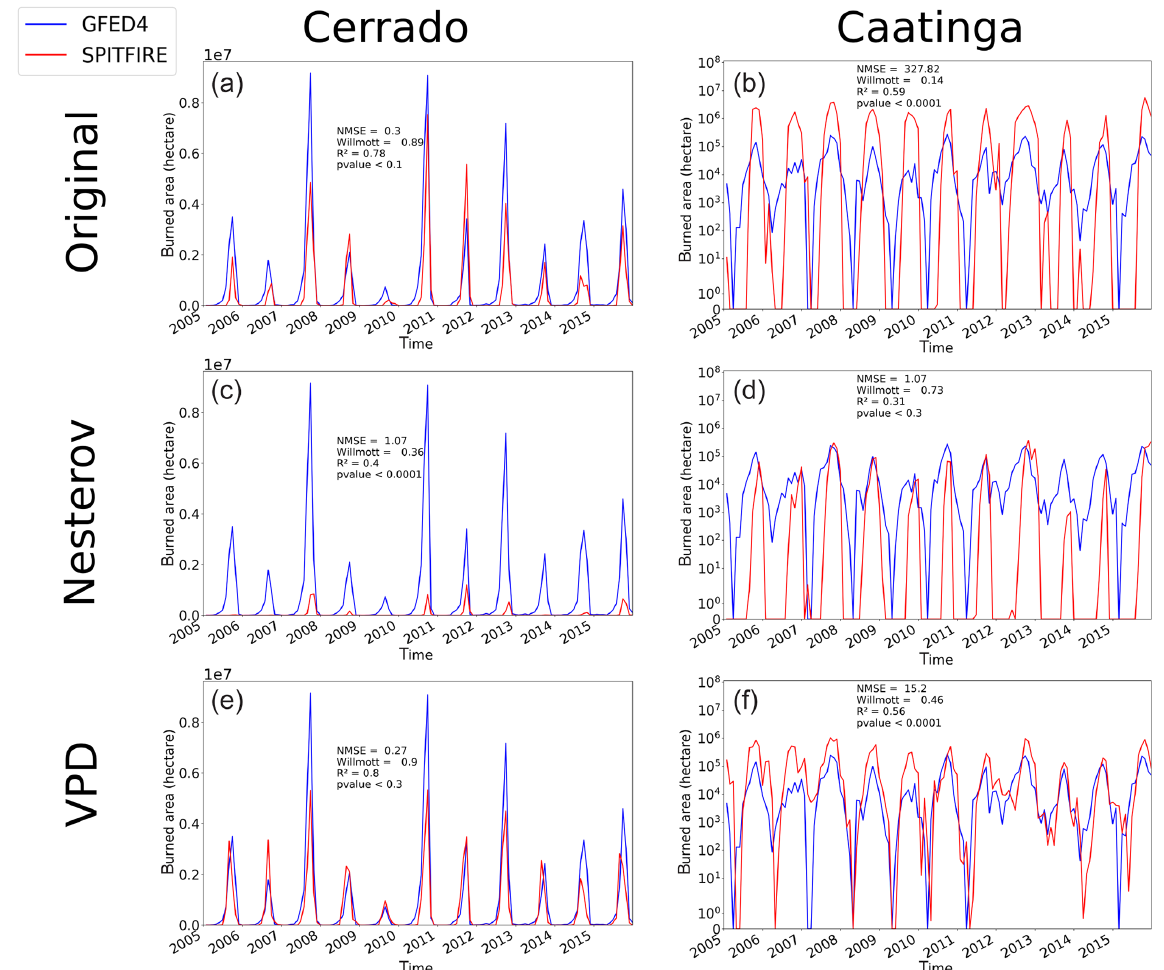
Figure 5. Time series of monthly burned area from 2005 to 2015 simulated by SPITFIRE (red lines) compared to GFED4 evaluation data (blue lines) for (a) the Cerrado region using NI orig , (b) the Caatinga region using the NI orig , (c) the Cerrado region using NI optim , (d) the Caatinga region using NI optim , (e) the Cerrado region using VPD optim , and (f) the Caatinga region using VPD optim . Note the logarithmic scale for the Caatinga, which was applied in order to account for the large differences between the different model versions (for a nonlogarithmic version see Fig.